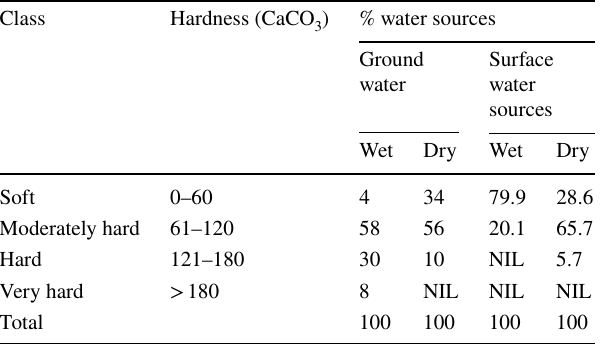
Table 5 Classification of water sources based on TH (mg/L) Class Hardness (CaCO 3 )